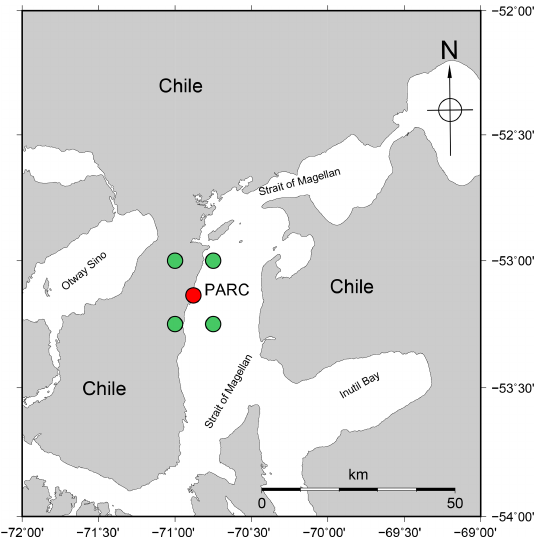
Figure 6. Location of GNSS station PARC along with the four grid points around the station. The grid points correspond to ERA-